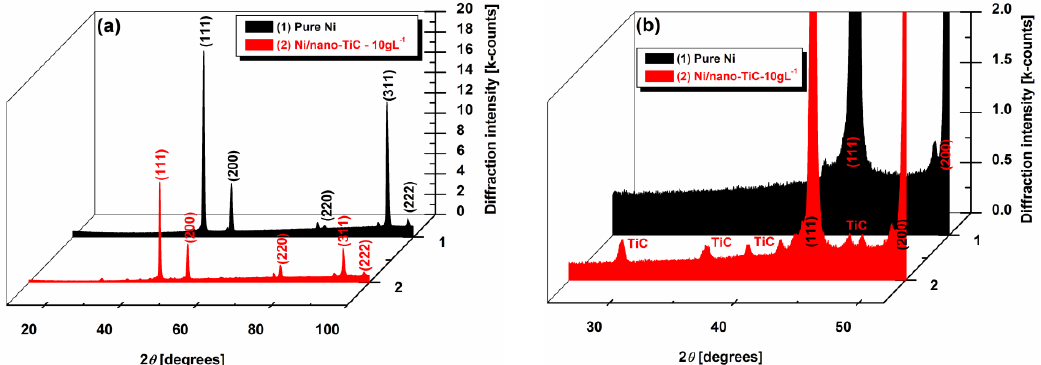
Figure 11. XRD patterns of: (1) pure Ni and (2) Ni/nano-TiC (10 g · L −1 ) functional coatings produced under same experimental conditions, at ( a ) a full magnification; ( b ) a zoom in the scale range to see diffraction peaks of TiC particles embedded into nickel matrix. Table 1. Diffraction peak intensities of the pure nickel and Ni/nano-TiC functional composite coatings.